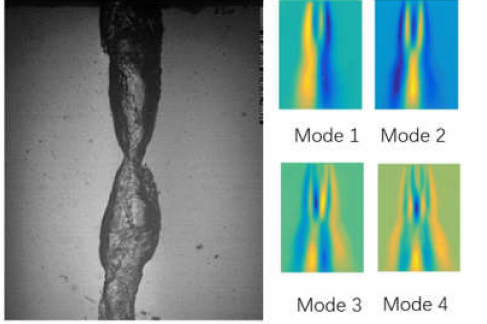
Figure 11. POD modes of vapor cavity structures at n = 860 r/min, Q = 0.031 m 3 /s, and dP = − 83